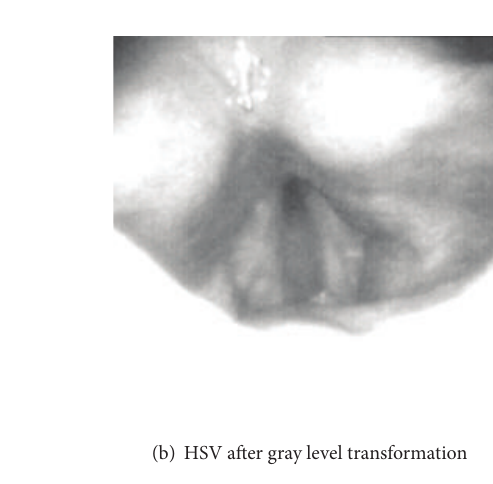
Figure 10: Application to a low contrast HSV.